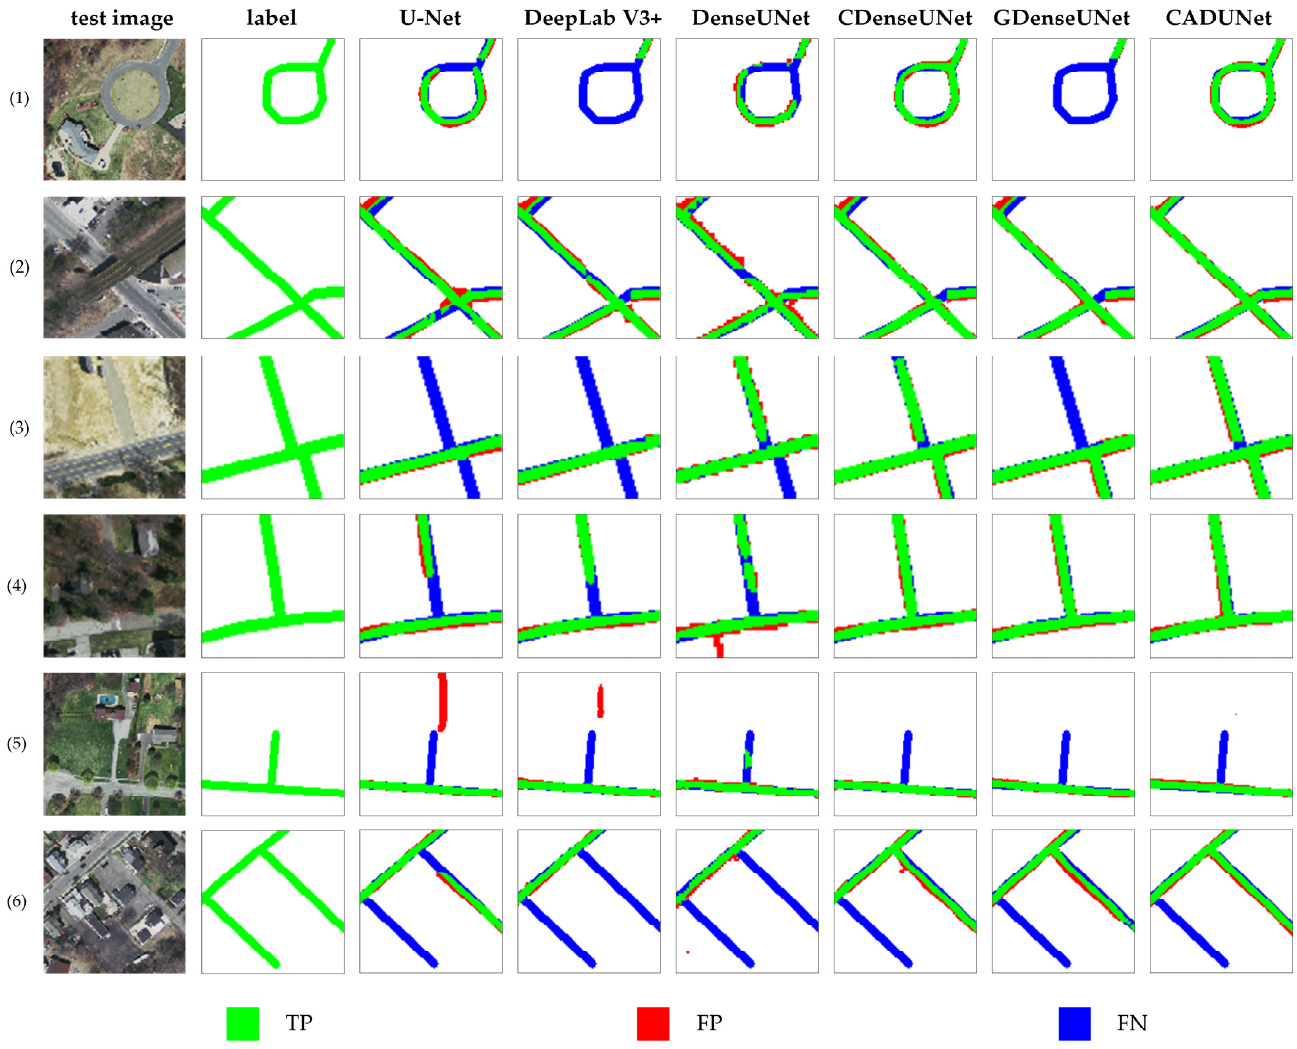
Figure 11. Visual accuracy assessment of road extraction based on the Massachusetts dataset. ( 1 ) The loop road; ( 2 ) The road sheltered by the elevated railway; ( 3 ) The intersection of the main road and the minor road; ( 4 ) The road occluded by dense tree canopies on the roadside; ( 5 ) The minor road connected to residential houses; ( 6 ) The main and minor road intersection area.